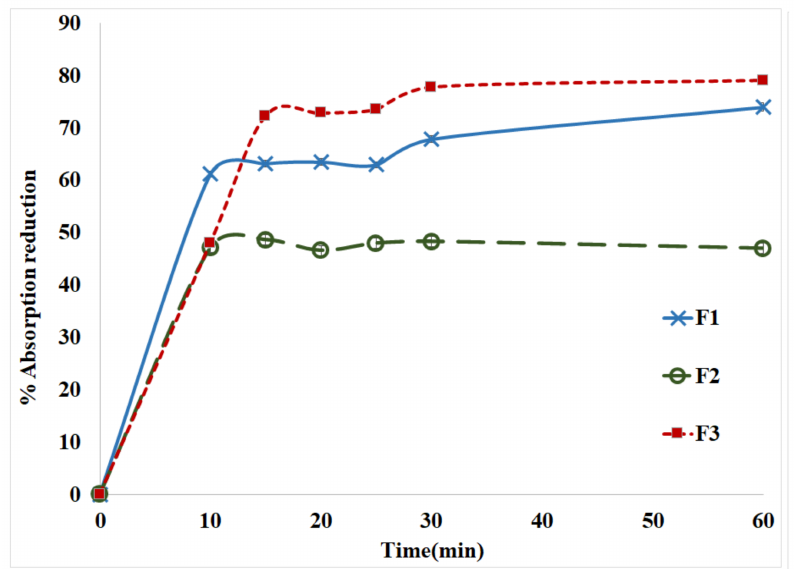
Figure 4. The percentage of absorption reduction for F 1 (1:1), F 2 (1:2) and F 3 (2:1) (the ratio of MTX-CS-NPs to TiO 2 ) versus time measured at λ max of 600 nm.